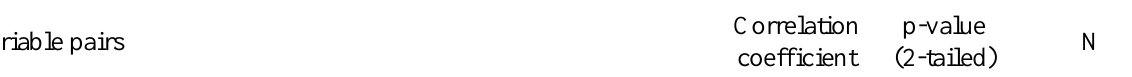
Table 3. Spearman’s correlation coefficients (2-tailed, p < 0.05) for the variable pairs that showed significant